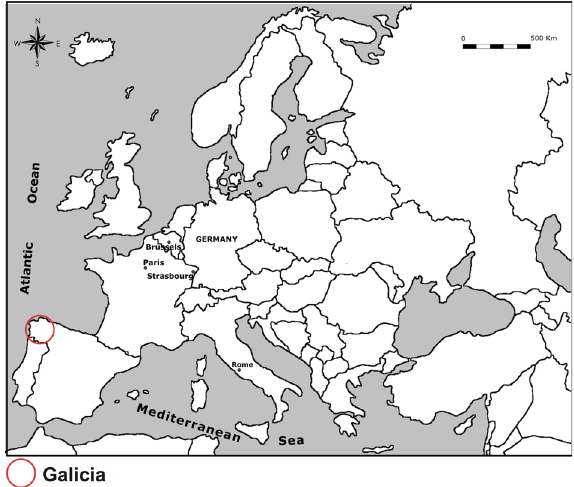
Fig. 3. Political map of Europe showing the imaginary spaces after the associated word test on students in training to be teachers in secondary education. Source: pre-associated word test on Europe, University of Santiago de Compostela,